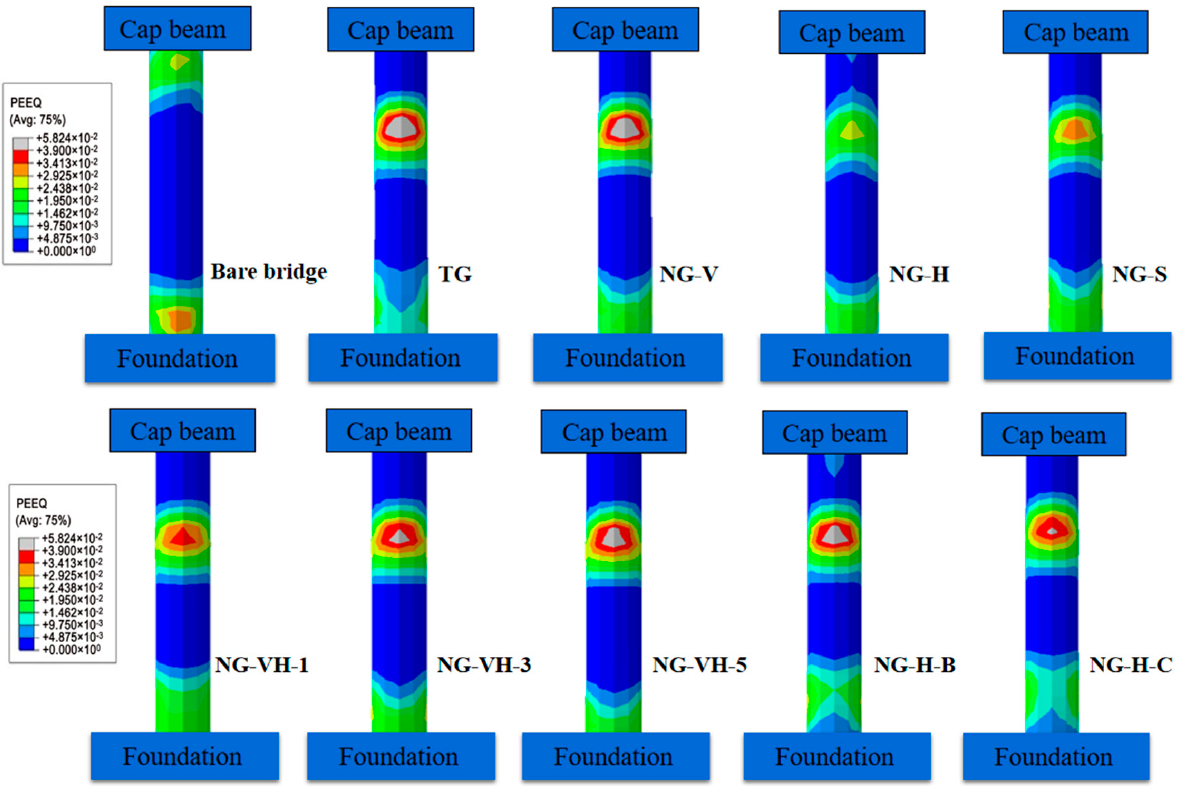
Figure 21. PEEQ on right pier columns at 3% drift.